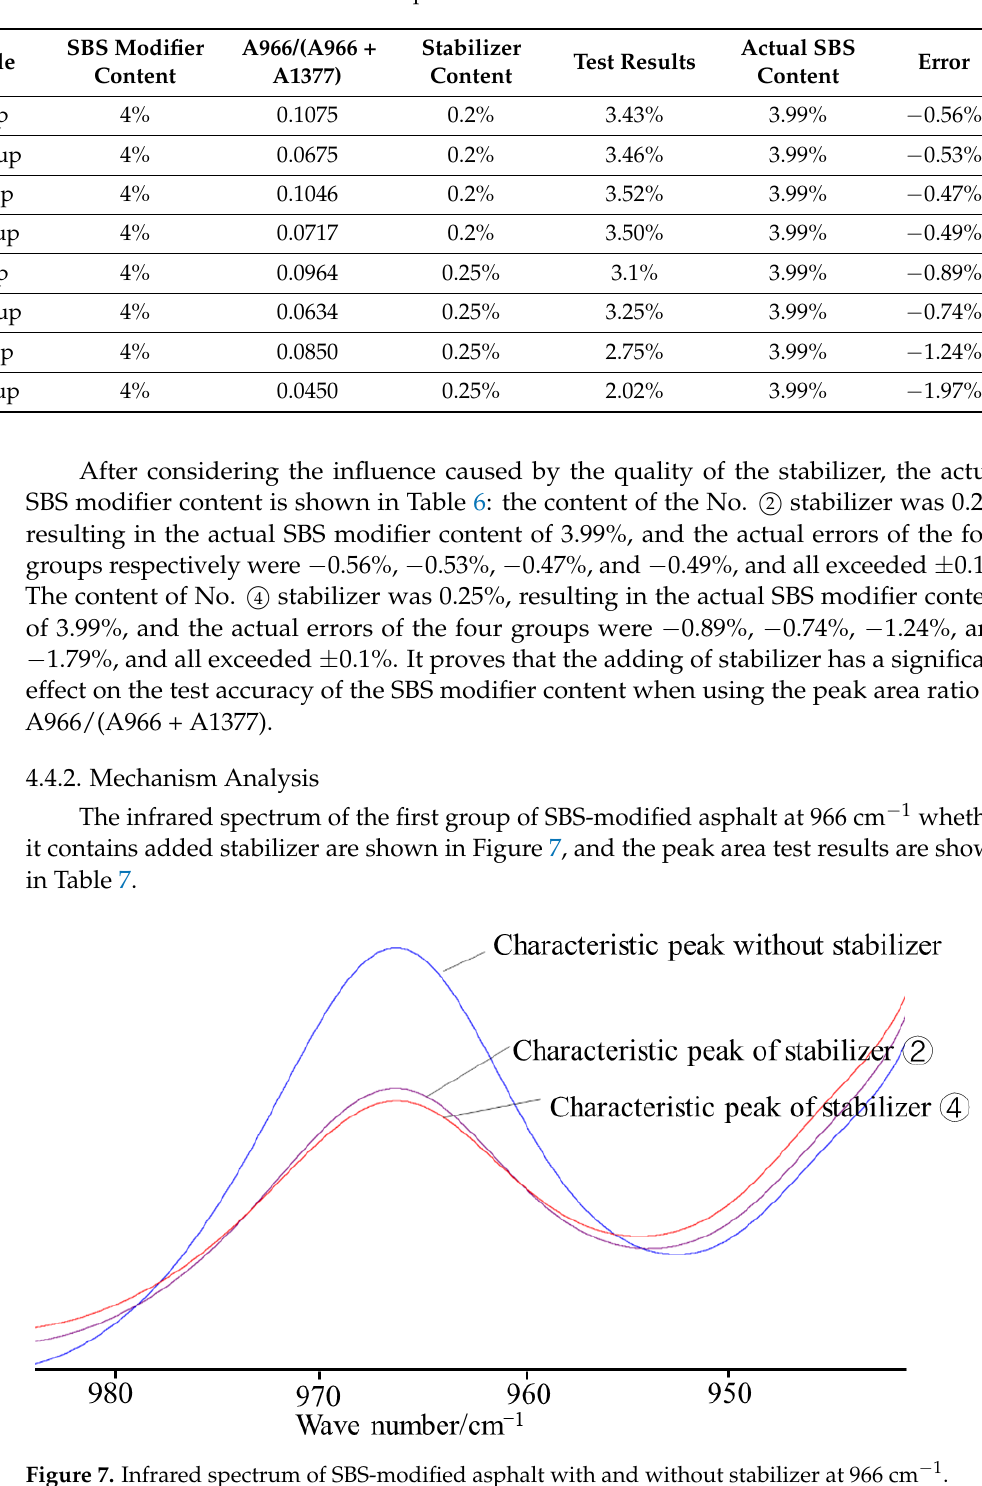
Figure 7. Infrared spectrum of SBS-modified asphalt with and without stabilizer at 966 cm − 1. Table 7. Test result of peak area ratio.